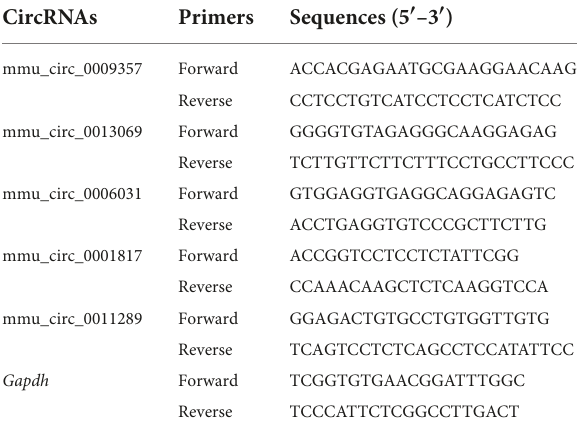
TABLE 2 The primers for circRNAs and the internal control gene.